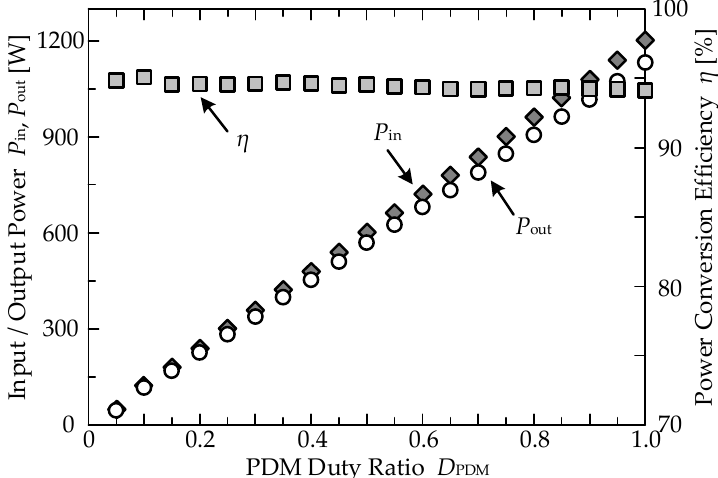
Figure 9. Power conversion efficiency and input/output characteristics.